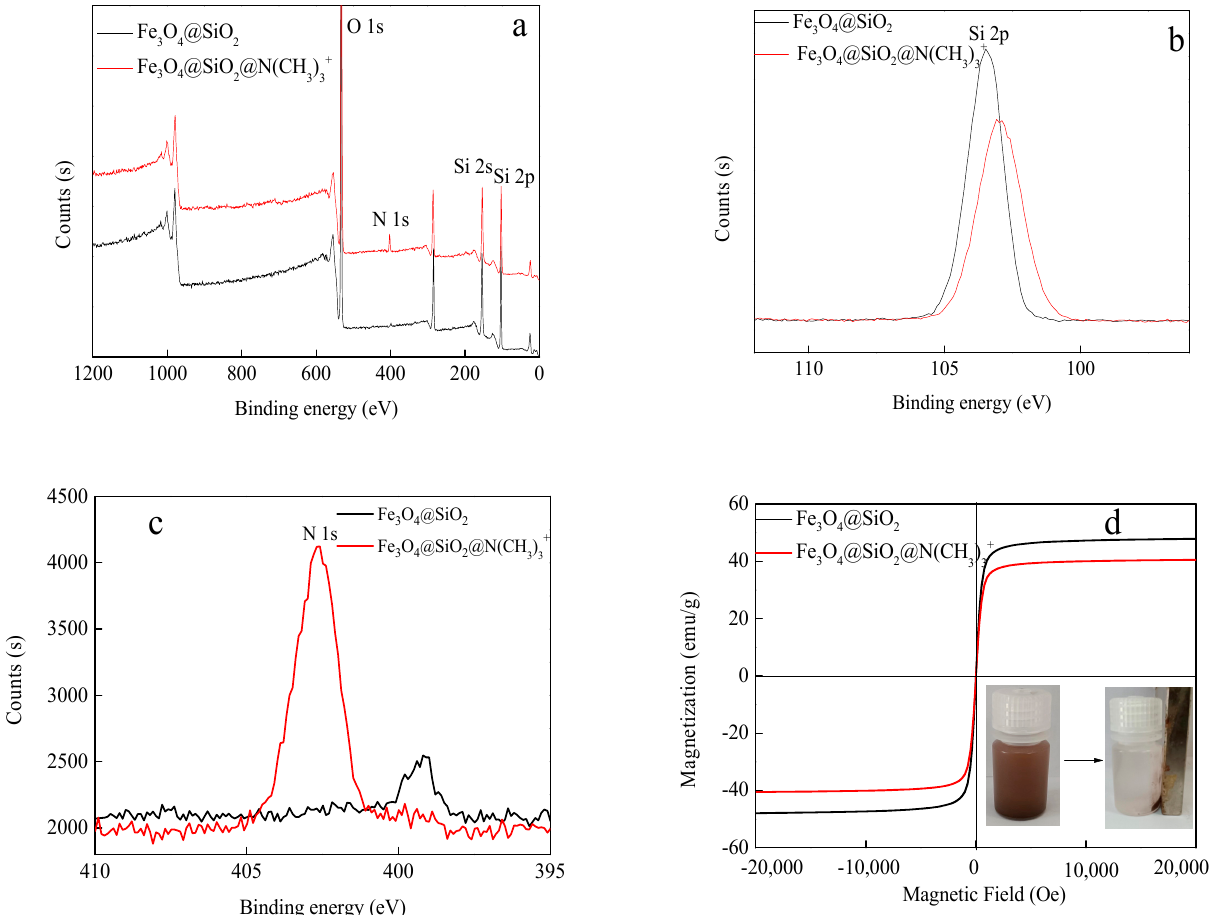
Figure 3. XPS scan of Fe 3 O 4 @SiO 2 and Fe 3 O 4 @SiO 2 @N(CH 3 ) 3+ : ( a ) survey, ( b ) Si 2 p, ( c ) N 1 s, and ( d ) VSM diagram of Fe 3 O 4 @SiO 2 and Fe 3 O 4 @SiO 2 @N(CH 3 ) 3+ .